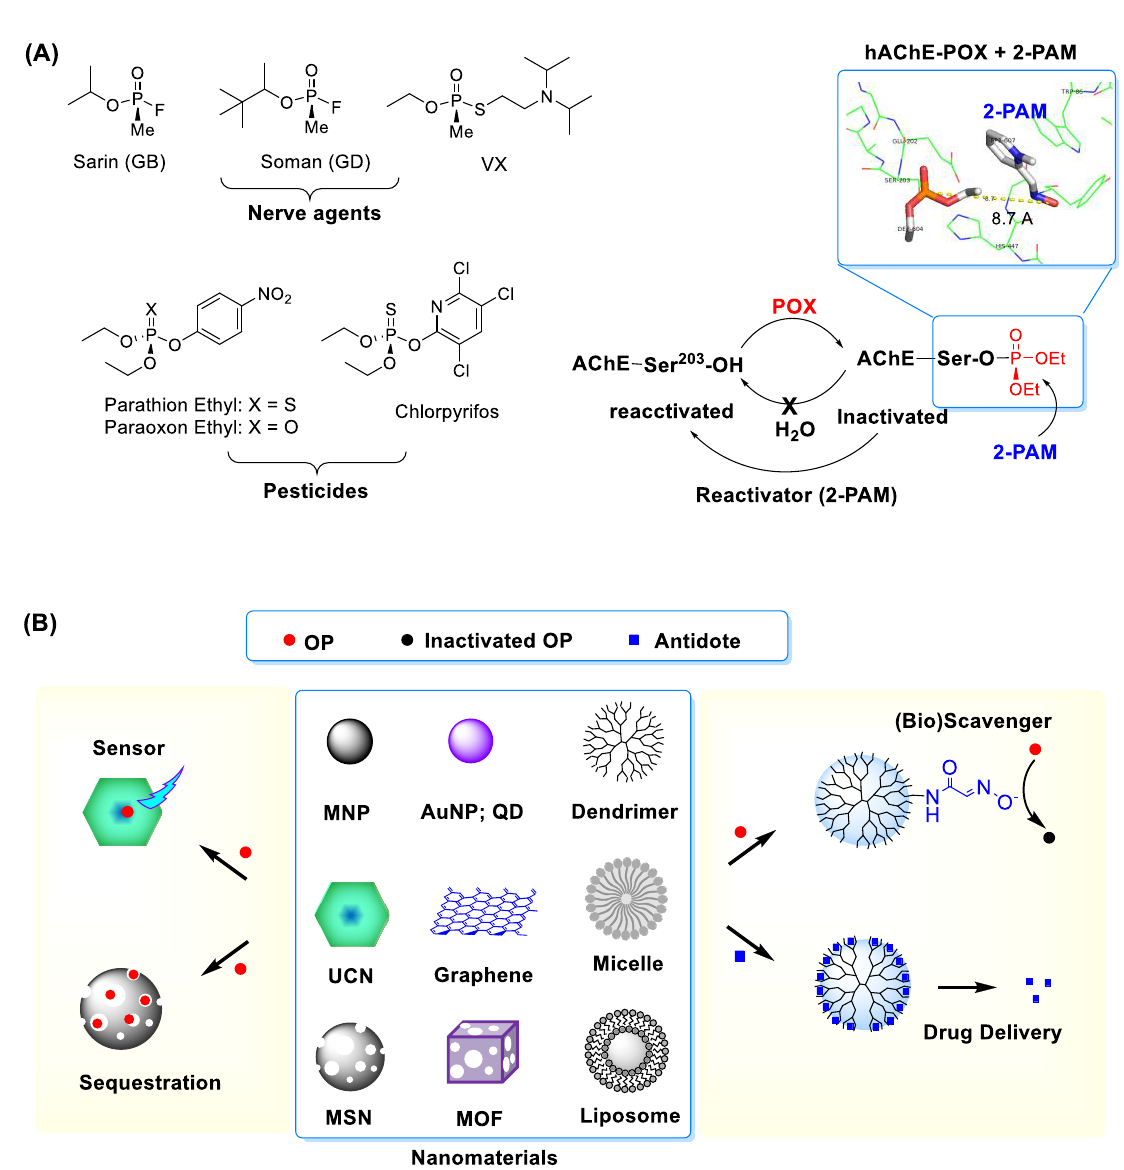
Figure 1. ( A ) (left) Types of representative organophosphates (OP) including nerve agents and pesticides and (right) covalent inhibition of acetylcholine esterase (AChE) by OP such as paraoxon ethyl (POX). Inset: An X-ray crystal structure for POX-inactivated human AChE in complex with 2-PAM, an enzyme reactivator which works by nucleophilic dephosphorylation (protein data bank (PDB) code 5HFA [10]). Adapted with permission from [16], Copyright 2019, The Royal Society of Chemistry. ( B ) Selected nanomaterials and their applications in OP detection and treatment. Abbreviations: MNP = magnetic nanoparticle, AuNP = gold (Au) NP, QD = quantum dot, MSN = mesoporous silica nanoparticle, MOF = metal-organic framework, UCN = upconversion nanocrystal.